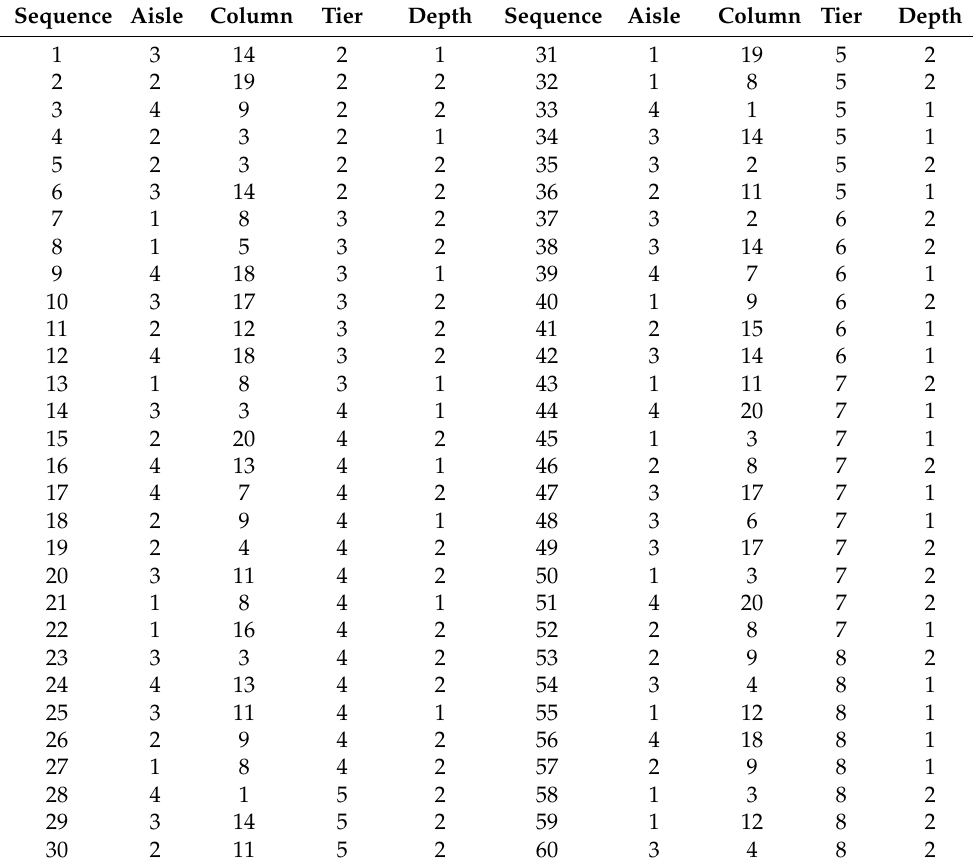
Table 3. All retrieval tasks and their original retrieval